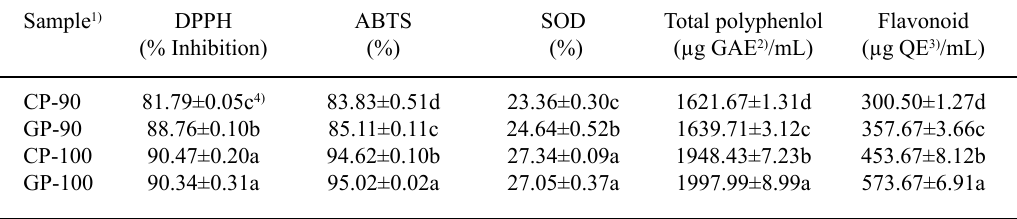
table 3. DPPH and ABTS radical scavenging activities, SOD-like activity, and total polyphenol and flavonoid contents of cultivated Pu-erh (CP) and Gushu Pu-erh (GP) tea extracts